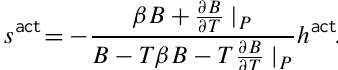
Figure captions Fig.1. The pressure dependence of isothermal bulk modulus B at T =2273 for MgO with correlation coefficient R =0.999, based on data listed in Table 1